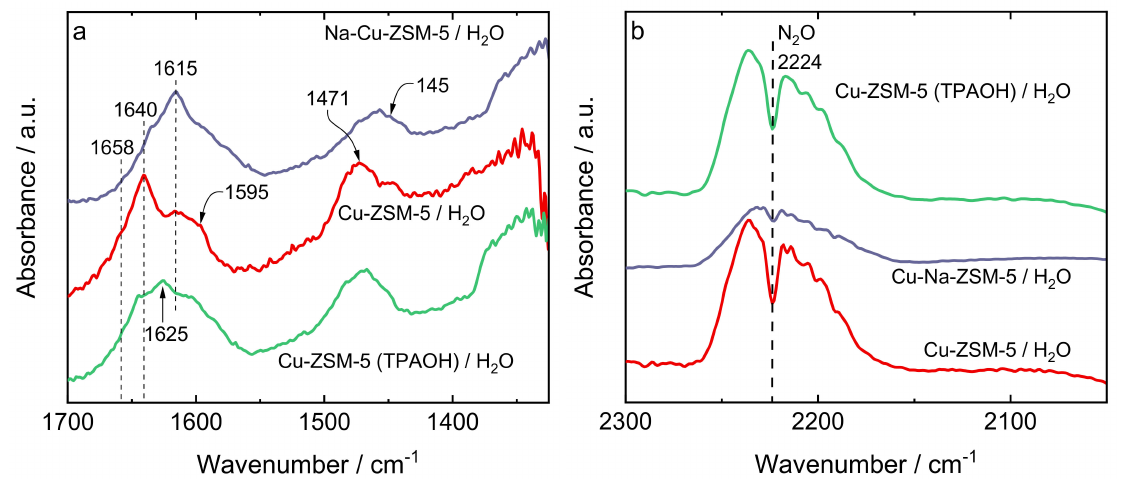
Figure 15. FT-IR difference spectra collected at 150 ◦ C after the adsorption NO, O 2 and NH 3 in the stoichiometric amounts ( c (NO)/ c (O 2 )/ c (NH 3 ) = 4:1:4) on the Cu-exchanged ZSM-5 in the presence of water vapor (5 vol.%) in the range of: ( a ) 1700–1325 cm − 1 and ( b ) 2300–2050 cm − 1